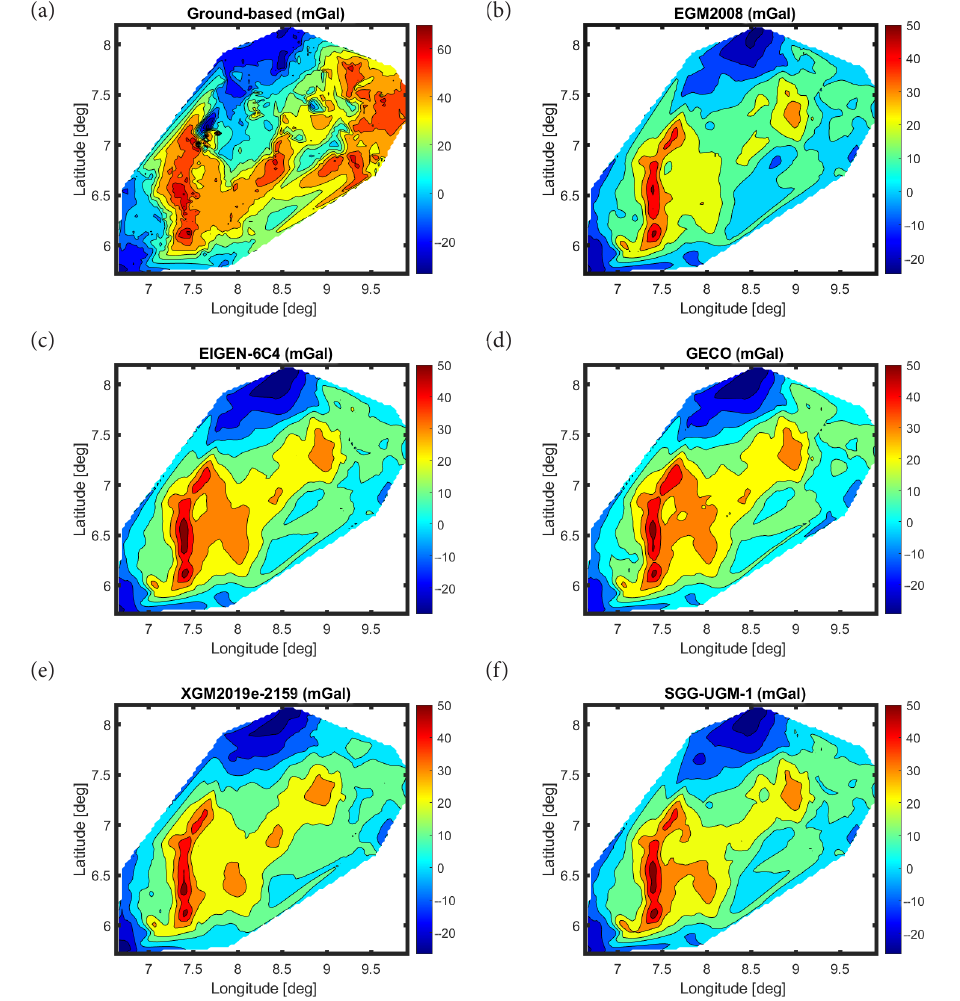
Figure 5. Ground-based versus GGM-derived free-air gravity anomalies: